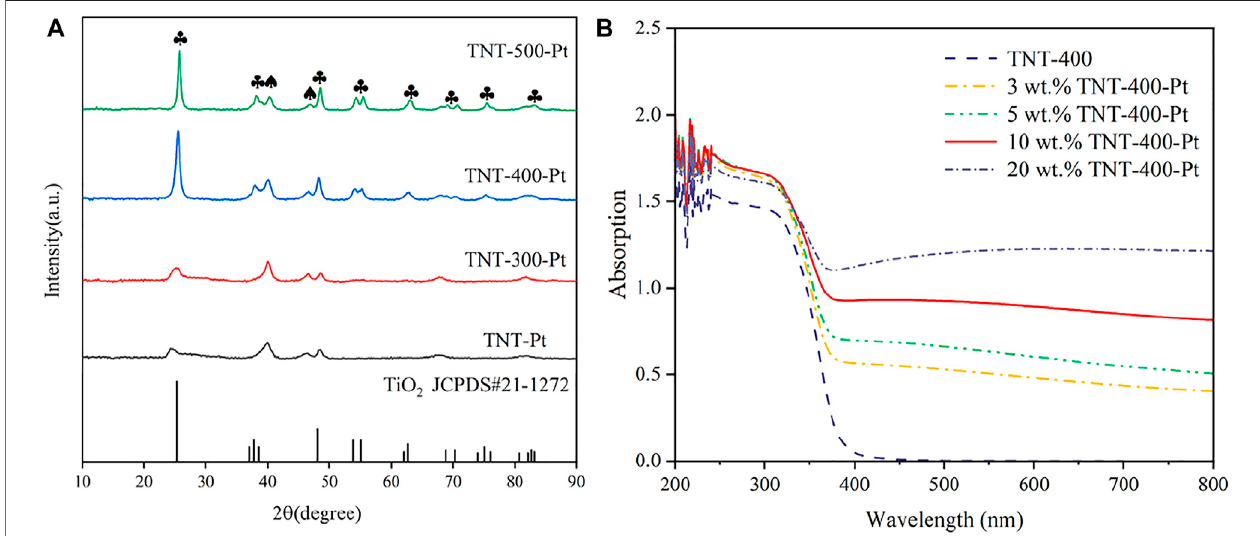
FIGURE 1 | XRD patterns of different samples with most important planes indicated (A) , and UV absorption of samples with different Pt loading (B) , ) : the typical diffraction peak of anatase, ( : the diffraction peak of Pt oxide.